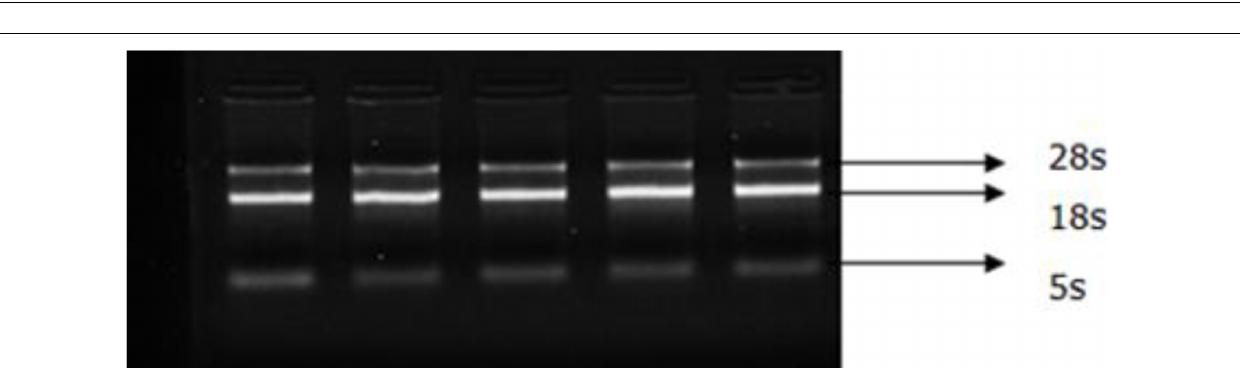
FIGURE 6 | Effects of melatonin on the expression of villi growth-related genes in Inner Mongolia cashmere goats. (A) The relative expression quantity of the Wnt10b gene. The square represents the experimental group; the circle represents the control group. The Wnt10b gene is expressed in different degrees in each month of the year in the control group and the experimental group. Control: no treatment; Melatonin: melatonin implantation. Values represent means ± SD, * P < 0.05 vs. untreated group. (B) The relative expression quantity of β -catenin gene, the square represents experimental group; the circle represents control group. The expression level of human-catenin gene was different in each month of the year in the control group and the experimental group.